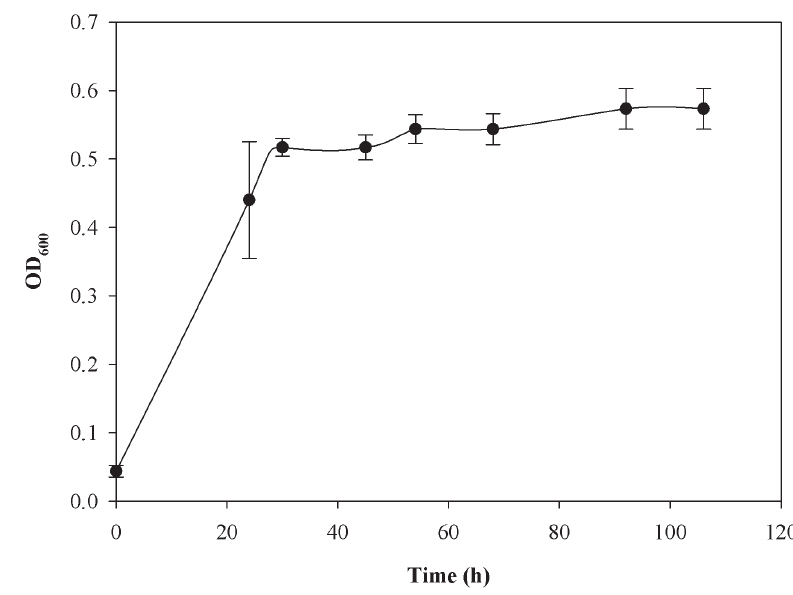
Fig. 4 – OD values of Clostridium 600